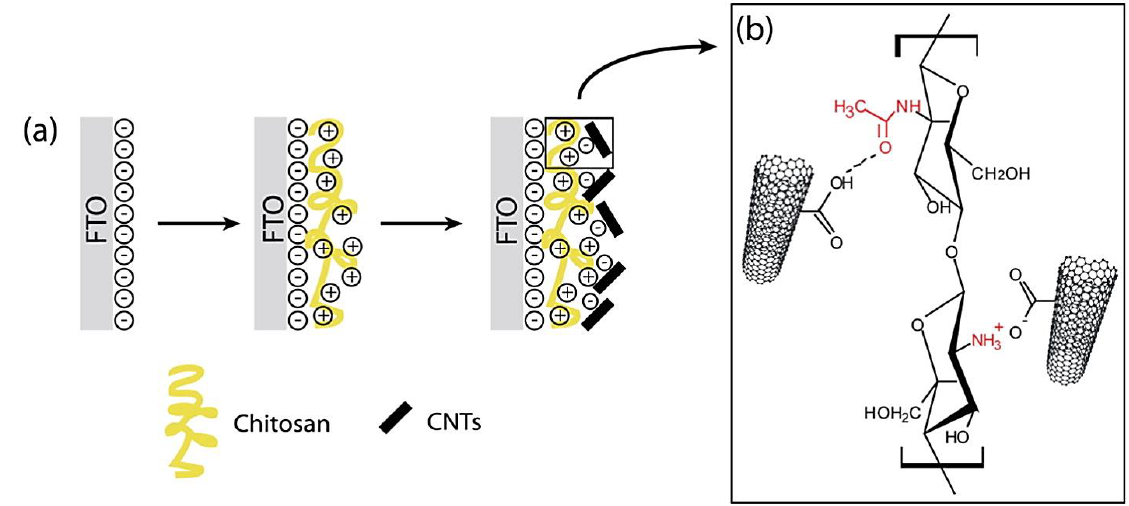
Figure 5. ( a ) Schematic representation of the layer-by-layer and ( b ) supramolecular interaction between chitosan and multi-walled carbon nanotubes (MWCNT) for 1-bilayer film (adapted by permission from Reference